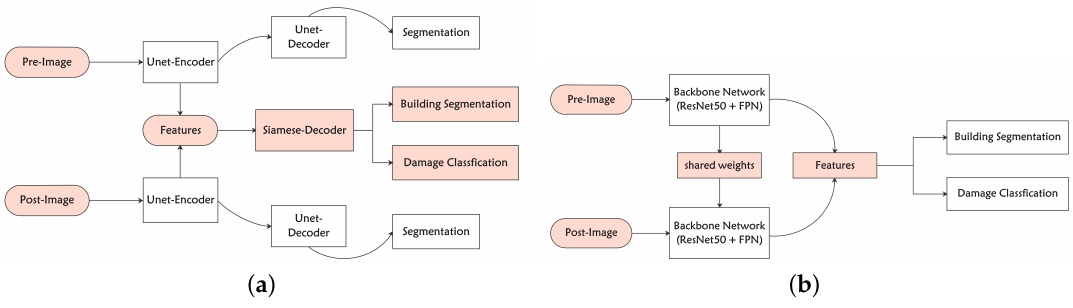
Figure 7. Examples of state-of-the-art end-to-end models. ( a ) The overall structure of the Siam-U-Net-Attn model [25] which uses a double U-Net model to generate binary masks. ( b ) The overall structure of the model in Weber et al. [26] which uses Mask R-CNN(Regions with CNN features) with FPN (Feature Pyramid Networks) architecture as the backbone.